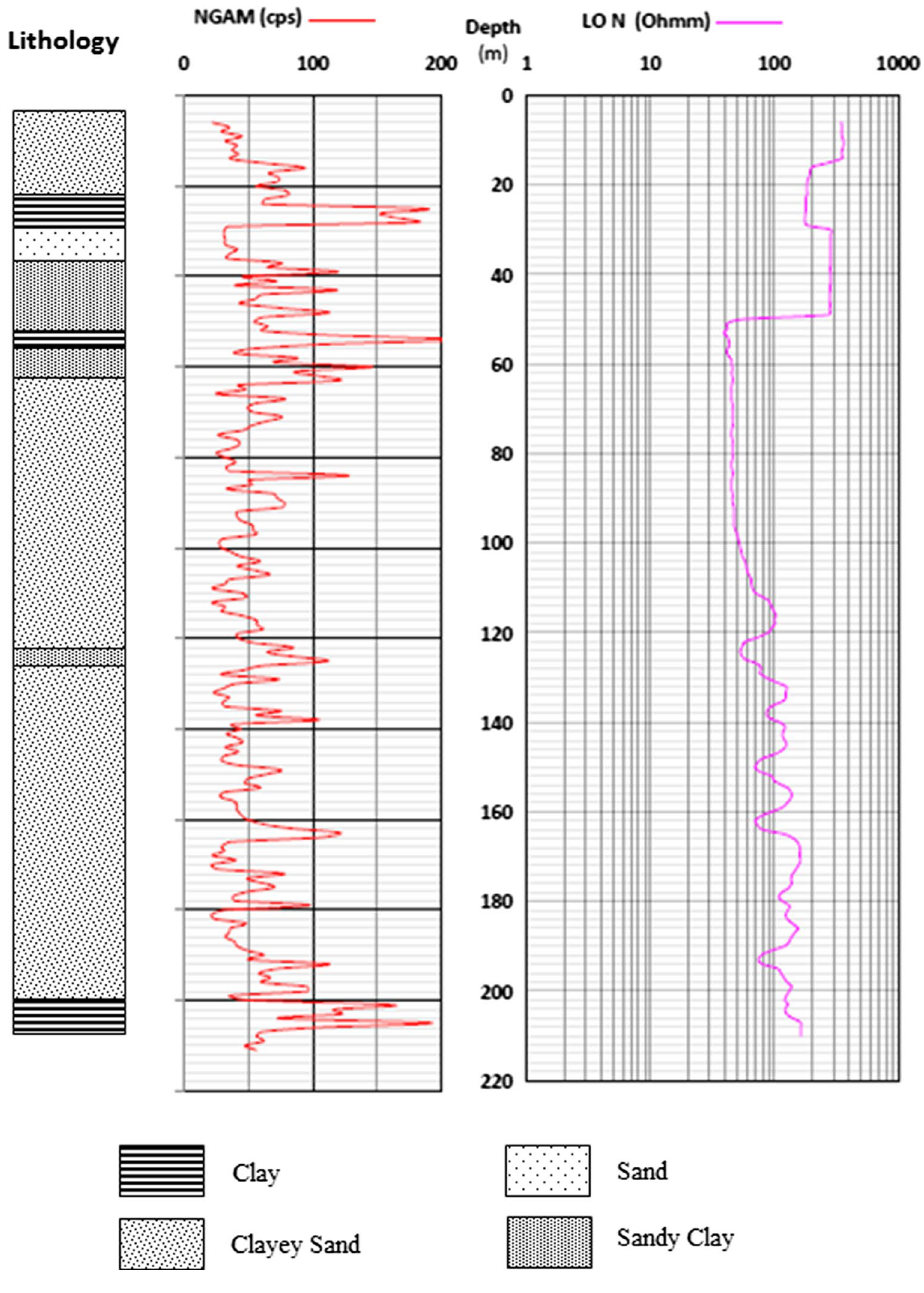
Fig. 3 Digitized lithologic and geophysical borehole logs of BH